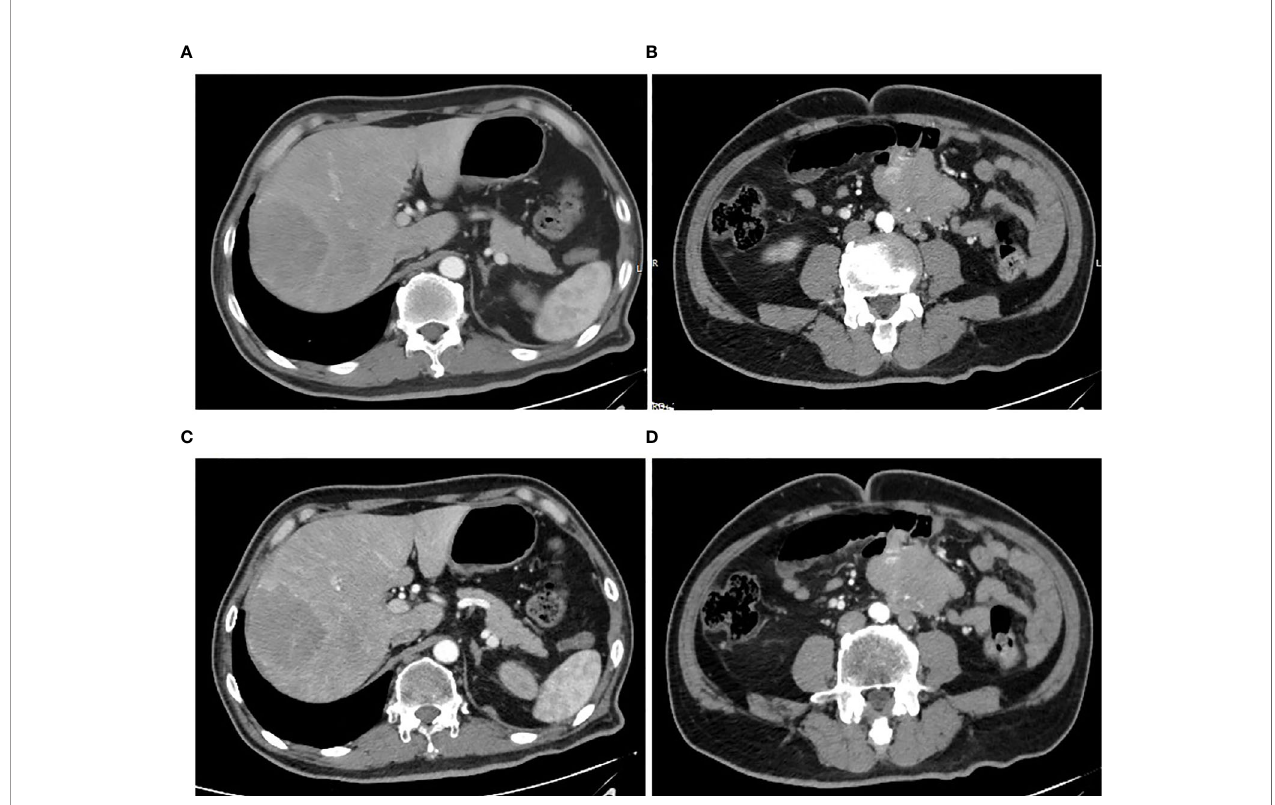
FIGURE 1 | Pretreatment CT images. (A, B) CT arterial and portal phase images of liver metastasis with a size of 70 mm × 61 mm, respectively. (C, D) CT arterial and portal phase images of abdominal & pelvic cavity metastasis with a size of 76 mm × 50 mm,